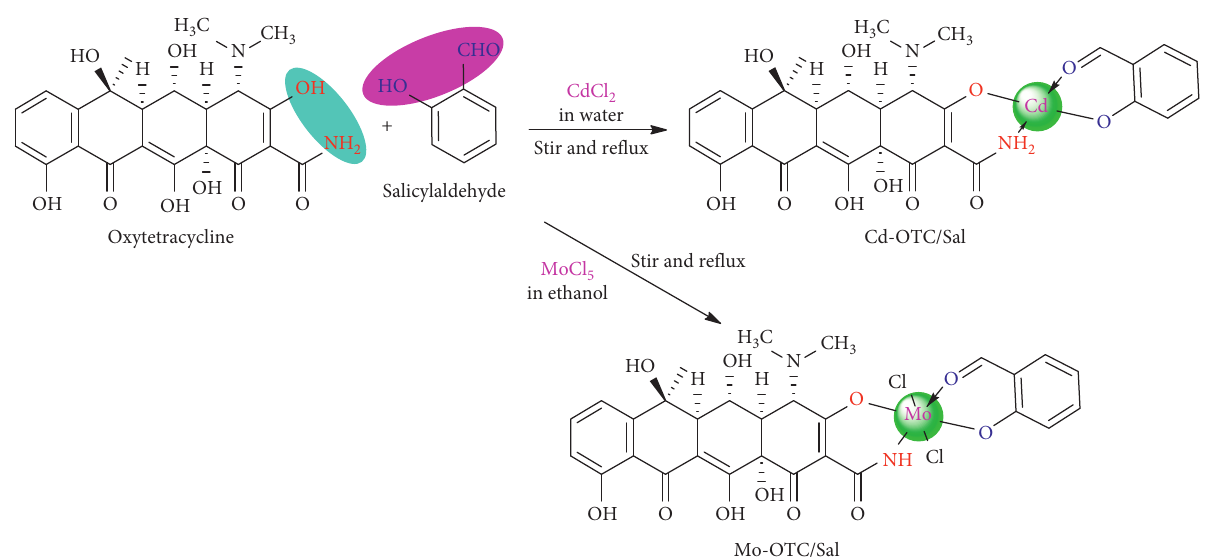
Scheme 1: Synthetic route for Cd(II) and Mo(V) metal